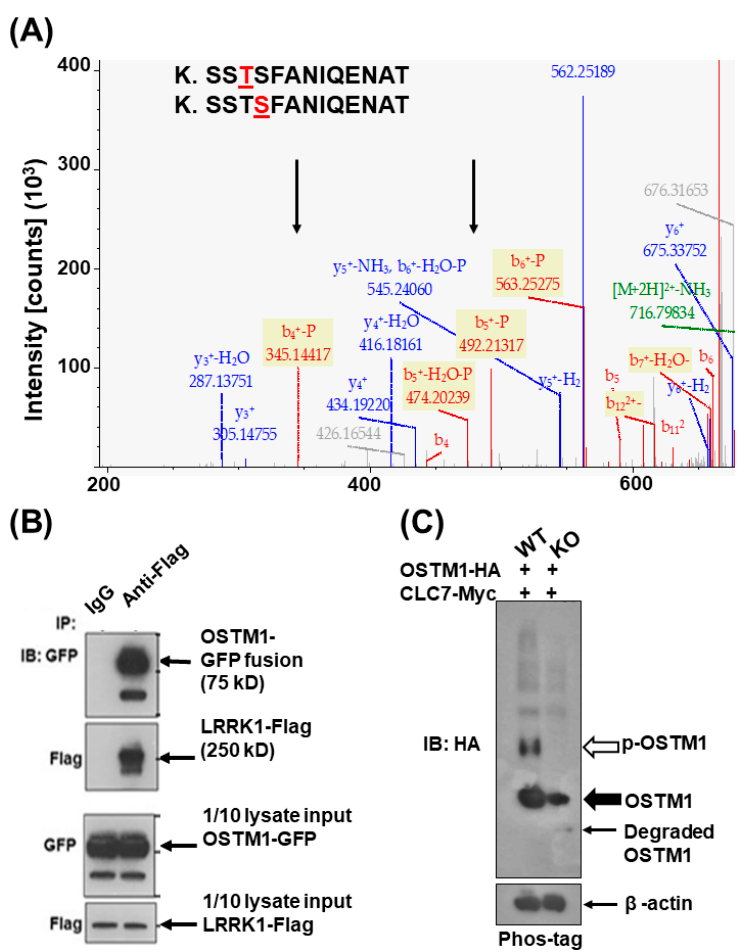
Figure 4. LRRK1 interacts with and stabilizes OSTM1 in osteoclasts. ( A ) Phosphorylation of OSTM1 at threonine 328 and serine 329 was detected in WT osteoclasts but not in LRRK1-deficient osteo- clasts by LC/MS. ( B ) LRRK1 interacts with OSTM1-GFP. Complex formation of LRRK1–Flag with OSTM1–GFP was detected by immunoprecipitation (IP) with an anti-Flag antibody, followed by immunoblotting (IB) with an anti-GFP antibody. ( C ) Phosphorylated OSTM1 is present in WT osteo- clasts. Phosphorylated proteins were resolved on 7% Phos-tag SDS-PAGE. Filled and open arrows indicate unmodified OSTM1-HA and phosphorylated OSTM1-HA, respectively. A small molecular weight peptide of degraded OSTM1 was detected only in LRRK1-deficient cells, as indicated by an arrow. The protein marker was not run on a Phos-tag